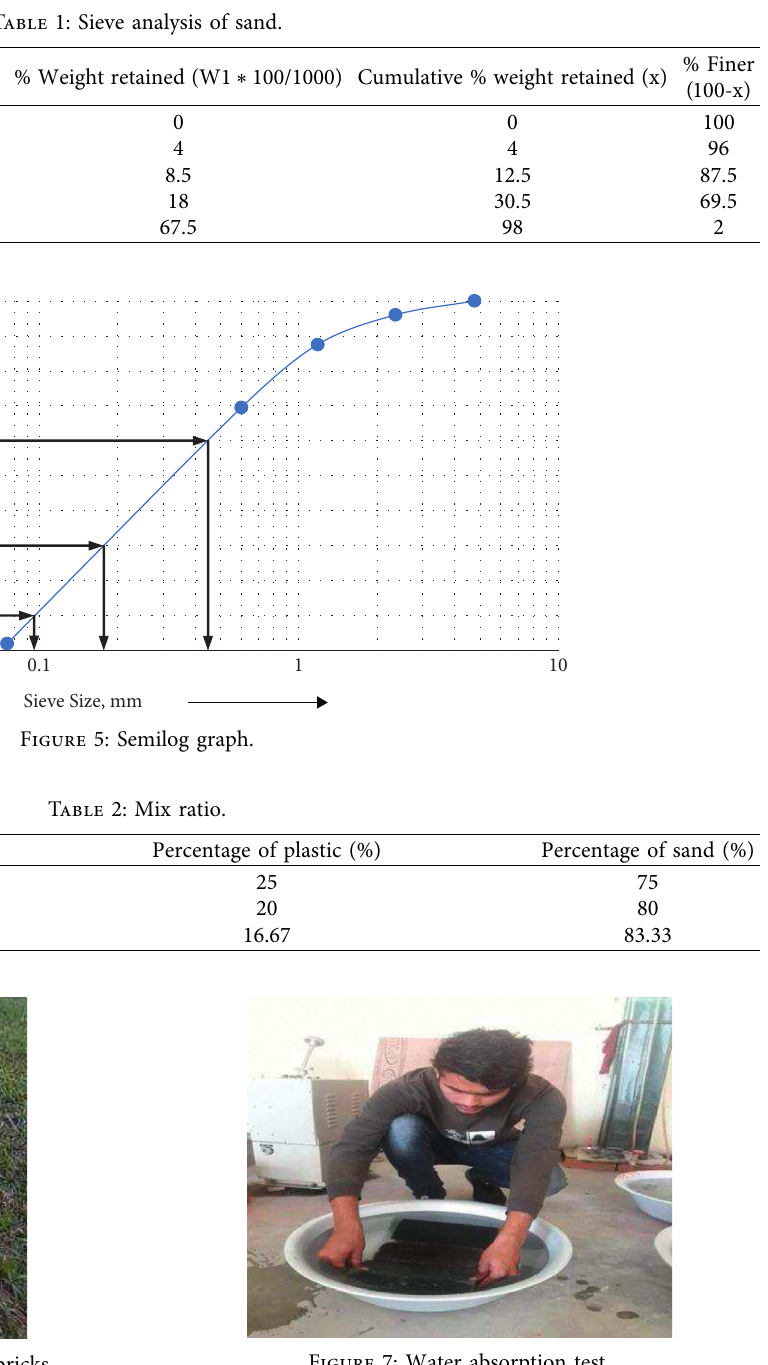
Table 1: Sieve analysis of sand.